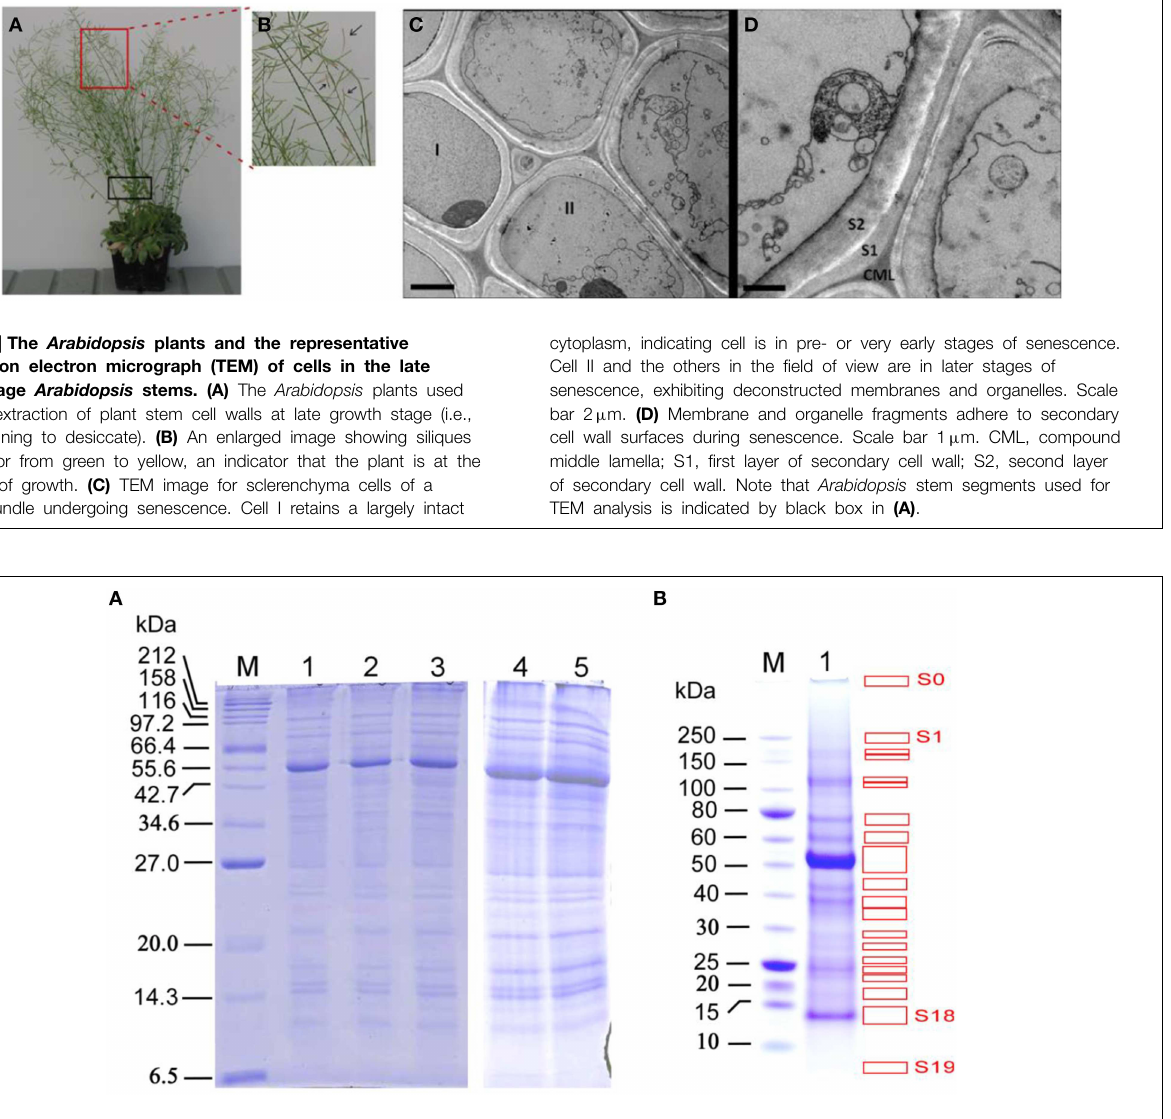
small- to medium-size proteins (15–75kDa). (B) SDS-PAGE separation of proteins used for in-gel digestion analysis, with 30 µ g per well. M: protein marker (#P7703, New England Biolabs, USA). NuPage 4–12% Bis-Tris gel was used for better separation of medium- to large-size proteins (30–250kDa), which resulted in 20 distinguishable strong bands (S0–S19, indicated by red boxes) and 25 weak bands (W1–W25; covering the remaining gel areas after strong bands were removed), which were used for digestion and subsequent LC-MS analysis. Note that the band S0 is the location of protein-loading